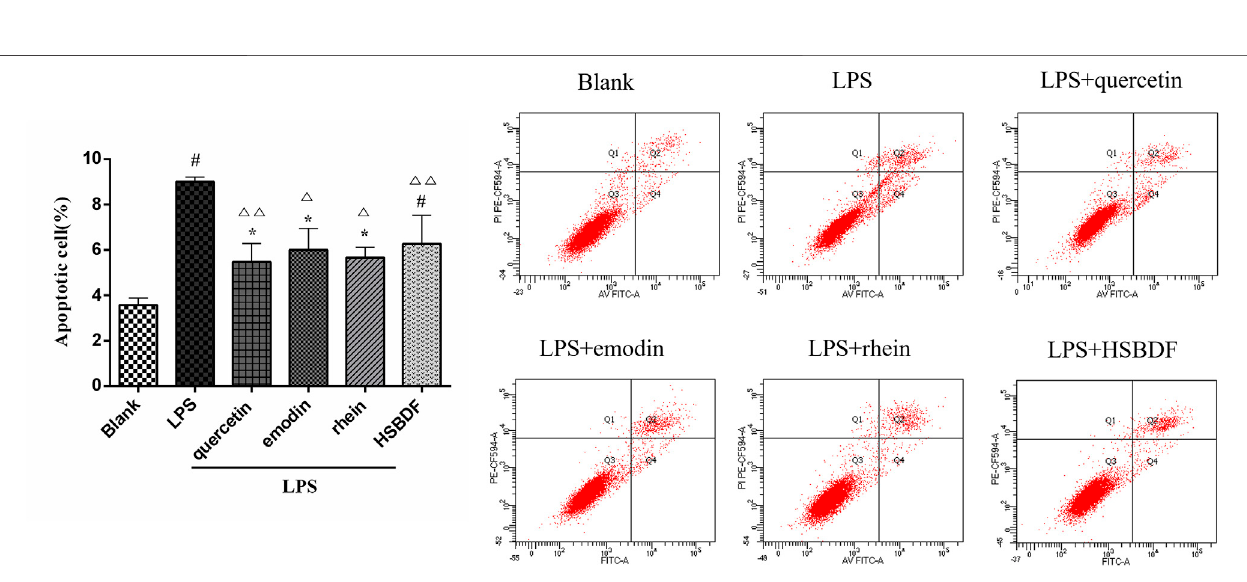
FIGURE7| EffectsofHSBDFandactivecompoundtreatmentonapoptosisinLPS-stimulatedA549cells(* p < 0.05, # p < 0.01versusblank; △ p < 0.05, △△ p < 0.01 versus